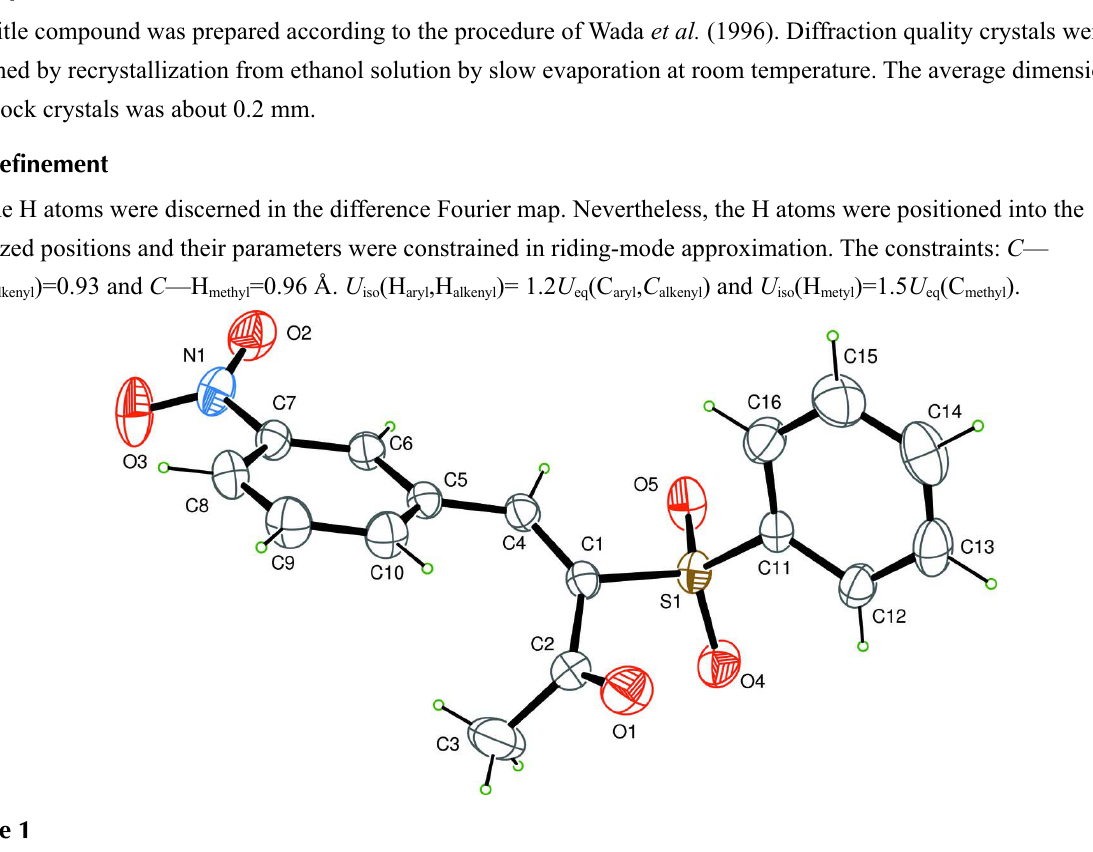
View of the title molecule showing the atom labelling scheme. The displacement ellipsoids are drawn at the 40% probability